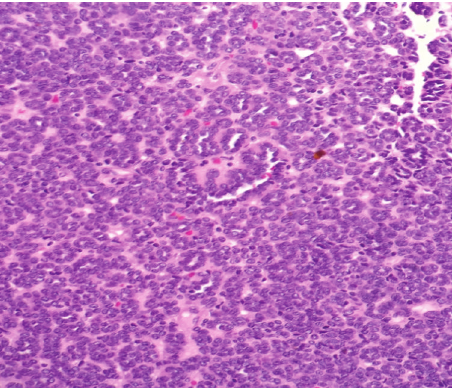
Figure 1: A micrograph of MA tissue at 200x magnification. There is a predominance of tightly packed small acini in the tumor.